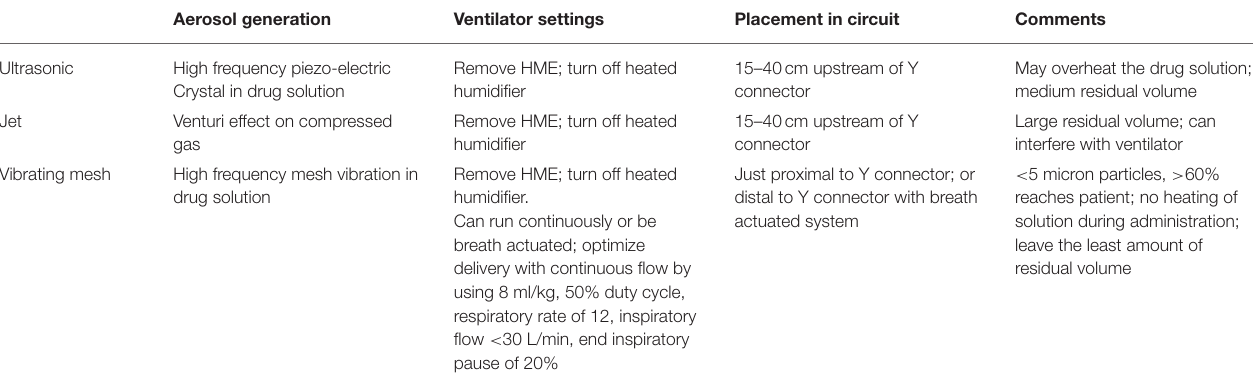
TABLE 1 | Nebulizer